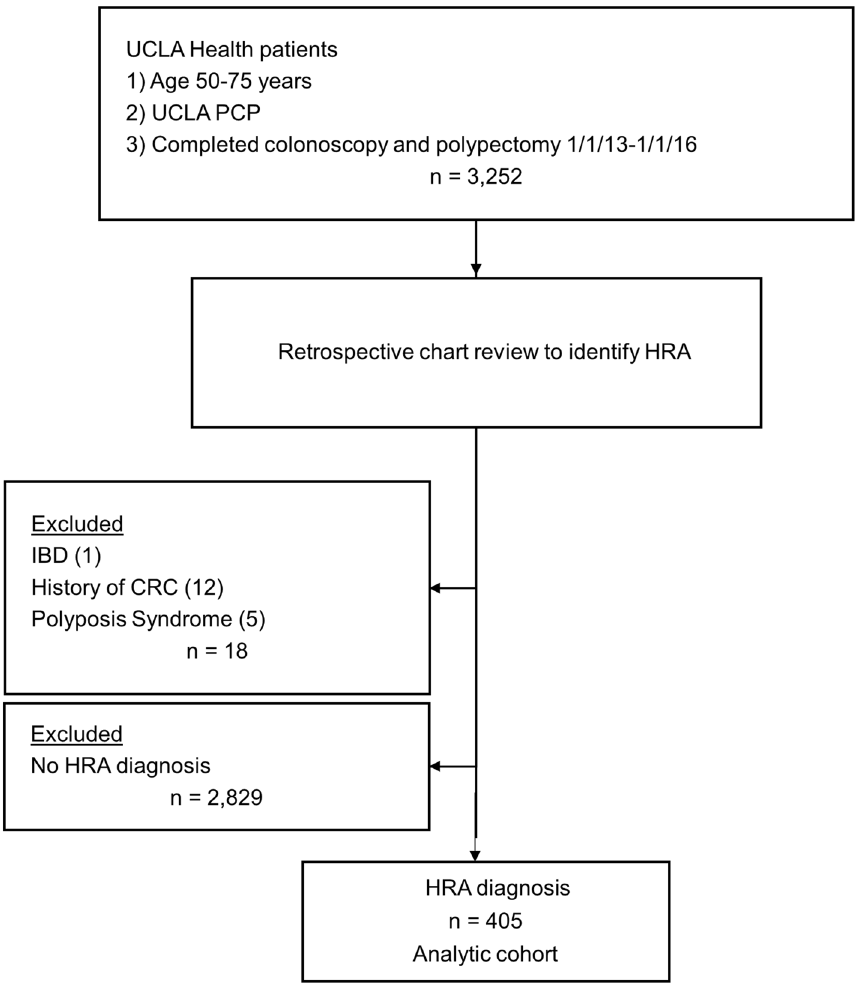
Figure 1. Flowchart of patient exclusions to obtain final analytic